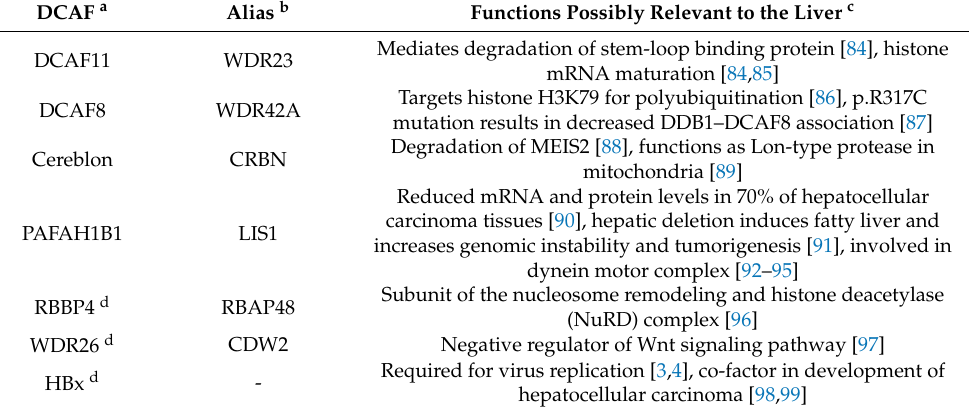
Table 2. DCAF receptor proteins identified in the CRL4 of human liver: Six DCAF receptor proteins were identified in the CRL4 complex from both uninfected and HBV-infected human hepatocytes. HBx, a viral DCAF receptor [26,29,83] (reviewed in Reference [34]), was also identified in the CRL4 from HBV-infected human